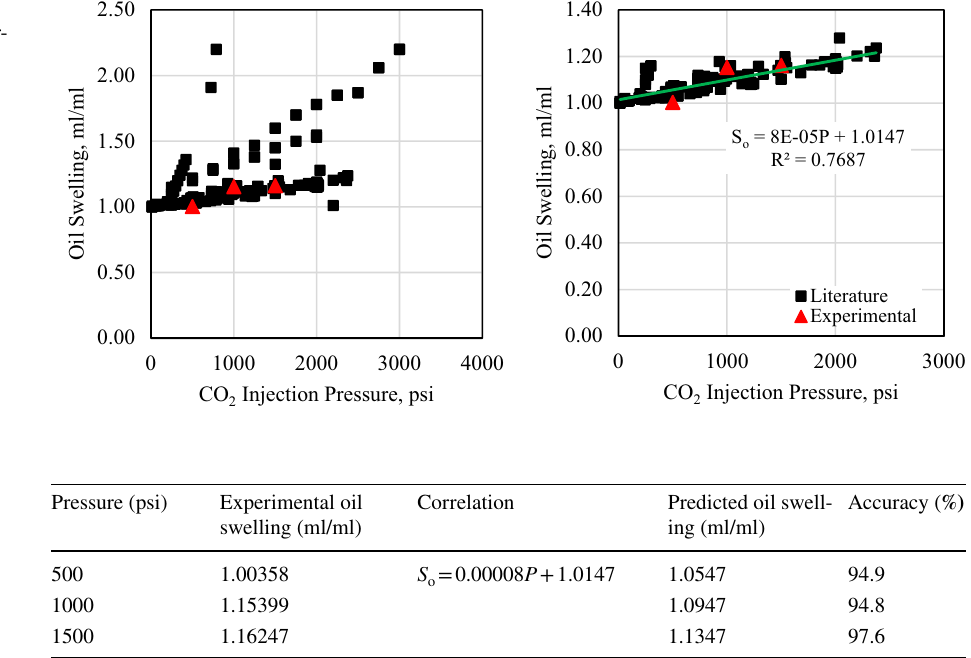
Table 2 Accuracy of CO injection pressure correlation